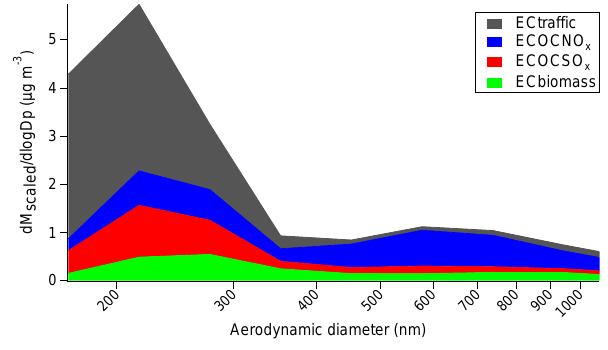
Fig. 3. Average scaled mass size distributions (stacked) for the 4 ATOFMS EC classes for the entire measurement period. The total corresponds to the average size-resolved scaled EC mass